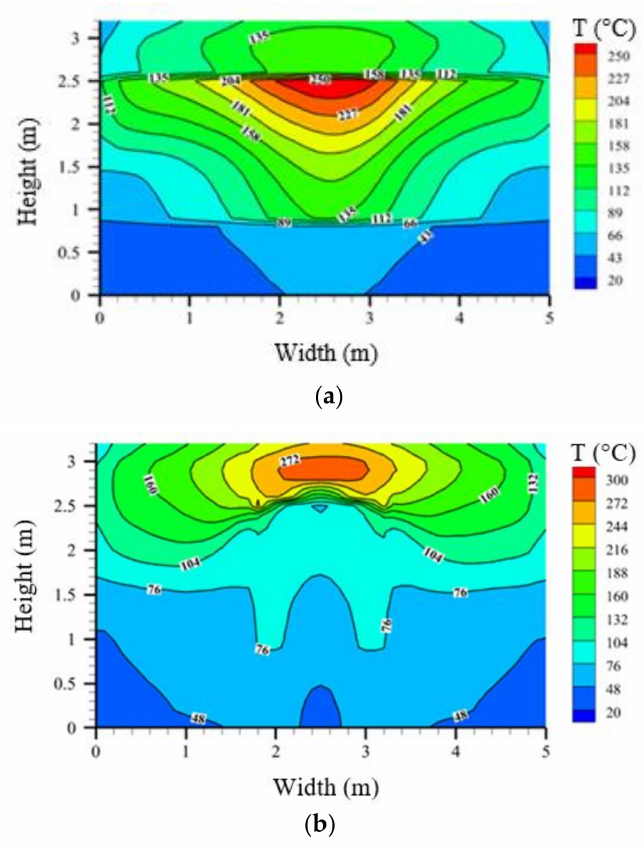
Figure 26. Temperature field of glass surface under window sprinkler conditions: ( a ) 50 s, ( b ) 150 s.